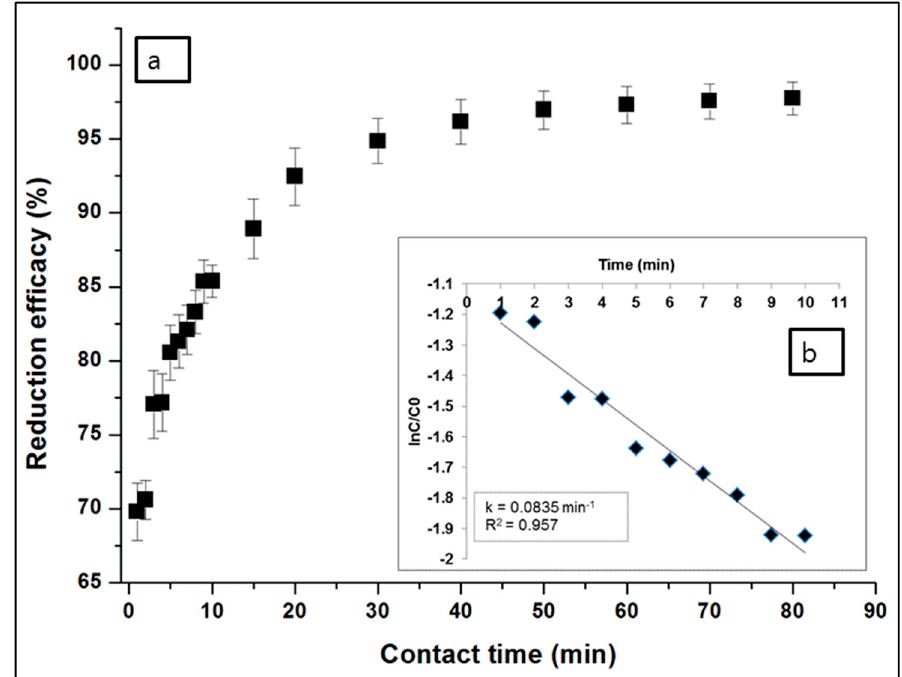
Figure 1. ( a ) Effects of contact time, [Cr(VI)] 0 = 10 mg·L − 1 , Cr(VI) volume = 25 mL, contact time = 0–80 min, pH = 2, plant leaves extract (PLE) quantity = 1.5 mL; ( b ) Pseudo first order rate kinetics of Cr(VI)